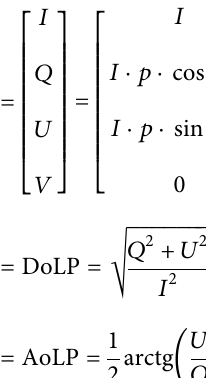
Figure 4: Polarization compensated two-mirror